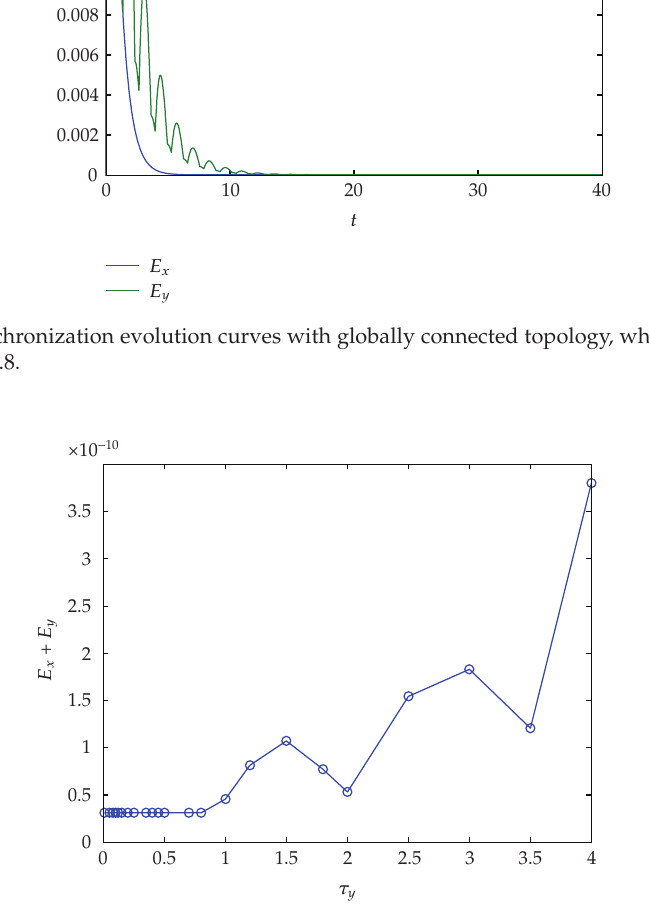
Figure 5: The curves of E x (cid:8) E y at t (cid:7) 40 versus τ y , with τ x (cid:7) 0 . 8, N x (cid:7) 50, and N y (cid:7)